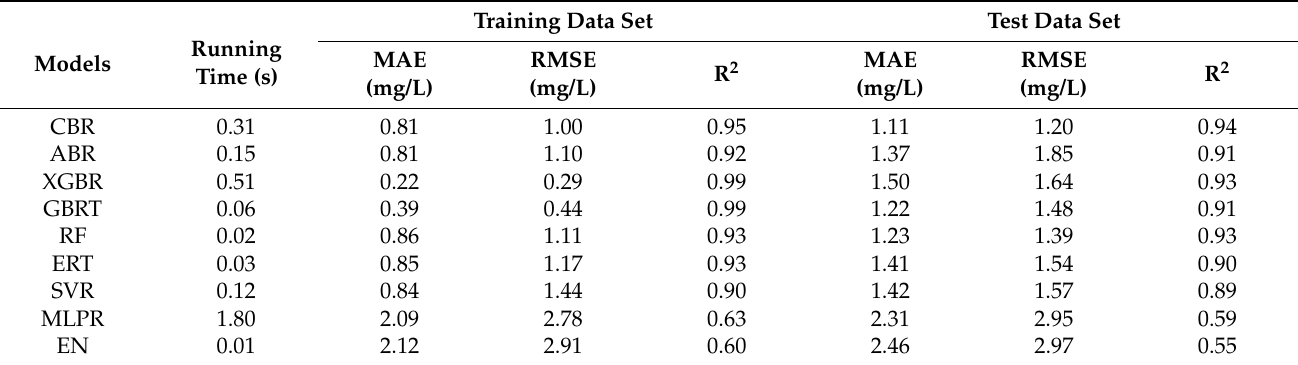
Table 5. Experimental results of SS (mg/L) using different